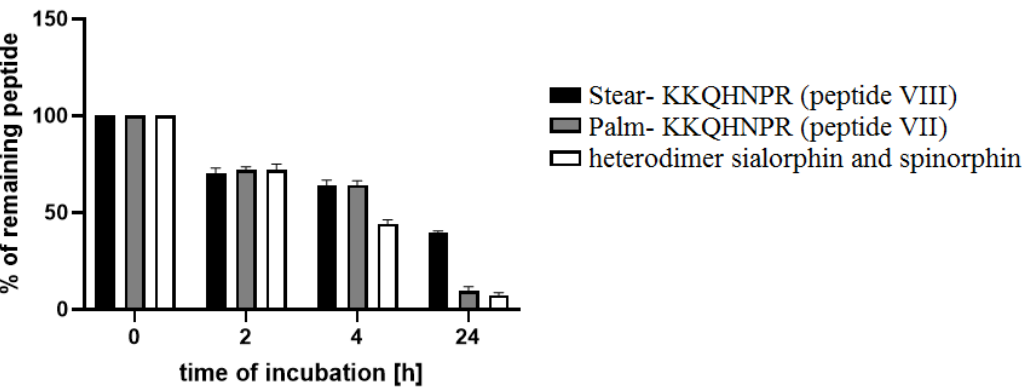
Figure 1. Conjugates sialorphin with a short lipopeptides: Palm-Lys-Lys (peptide VII ) and Stear- Lys-Lys (peptide VIII ) and heterodimer sialorphin and spinorphin stabilities in human plasma. The means of the % of remaining peptide with a standard deviation are presented.